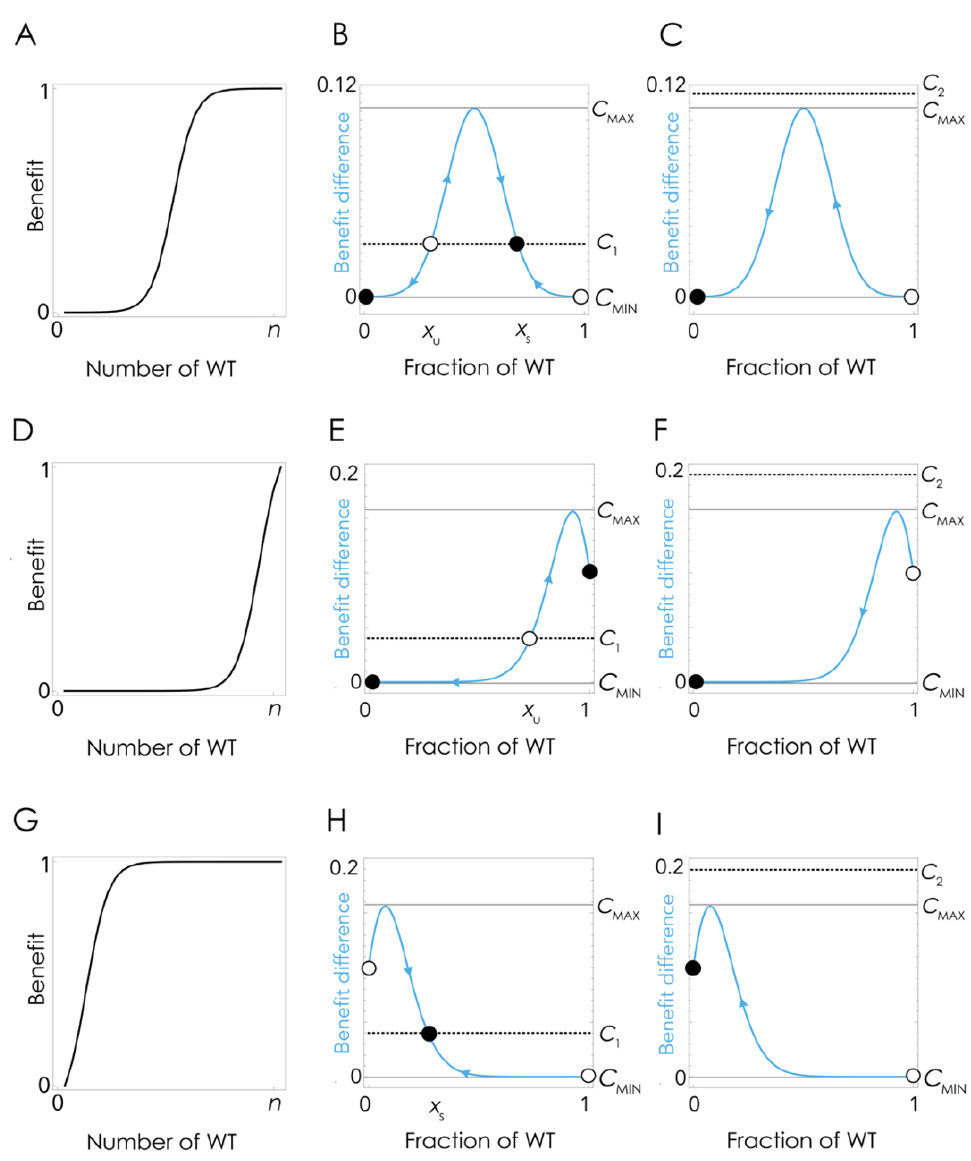
Figure 4. Evolutionary dynamics of cooperation for the production of growth factors. The black curves show the effect (benefit) of the growth factor as a function of the number of WT cells in the group (of size n ). The blue curves show the difference in benefit between WT and KO cells: W WT -W KO -c (assuming b = 1); when this is greater than the cost c, the fraction of WT cells increases in frequency. Hence, arrows show the direction of the dynamics, and circles show the equilibria (black: stable; white: unstable); The two mixed equilibria are labeled x S (stable) and x U (unstable). ( A ) Since growth factors have a nonlinear effect on cell proliferation, we assume that the benefit is a sigmoid function of the fraction of WT cells; here, n = 30, s = 30, h = 0.5. ( B ) If the cost/benefit ratio of the growth factor is below a critical level c MAX , for